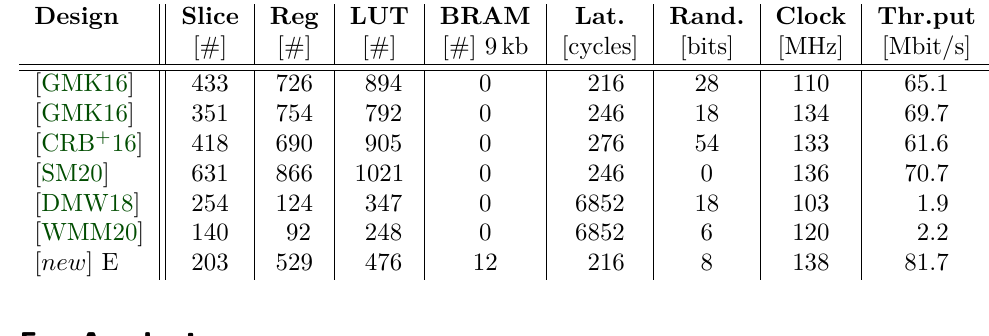
Table 3: Comparison of area-optimized (byte-serial) implementations including PRNG (with key masking, mapped on Xilinx Spartan-6)